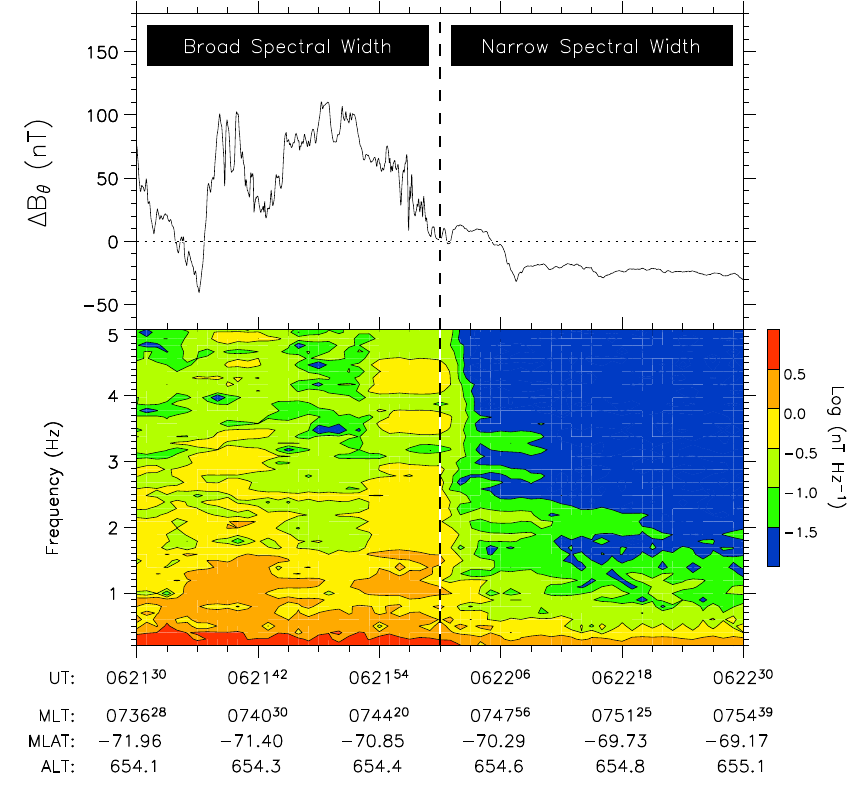
Fig. 4. (Top panel): An expanded plot of the 1B θ component (1-min interval from 06:21:30 to 06:22:30 UT). (Bottom panel): Dynamic spectra of the 1B θ component in the frequency range between 0.2 and 5Hz. The vertical dashed line indicates the time when Oersted crosses the spectral width boundary at 06:22